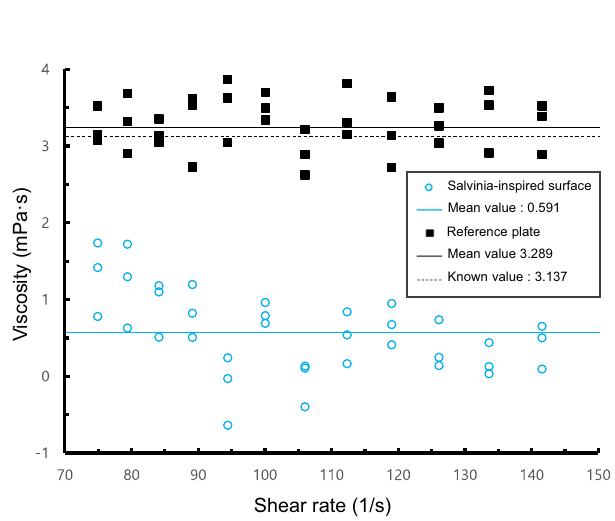
Shear rate (1/s) Fig. 7 | Apparent viscosity of 40 wt% glycerol on the reference plate and the Salvinia -inspiredsurfaces. Apparent viscosity of 40 wt% glycerol measured by the rotational rheometer on the reference plate (black squares), Salvinia - inspired surfaces (blue circles). Mean values for each case are indicated by solid lines, and the known value of the liquid is indicated by the dashed